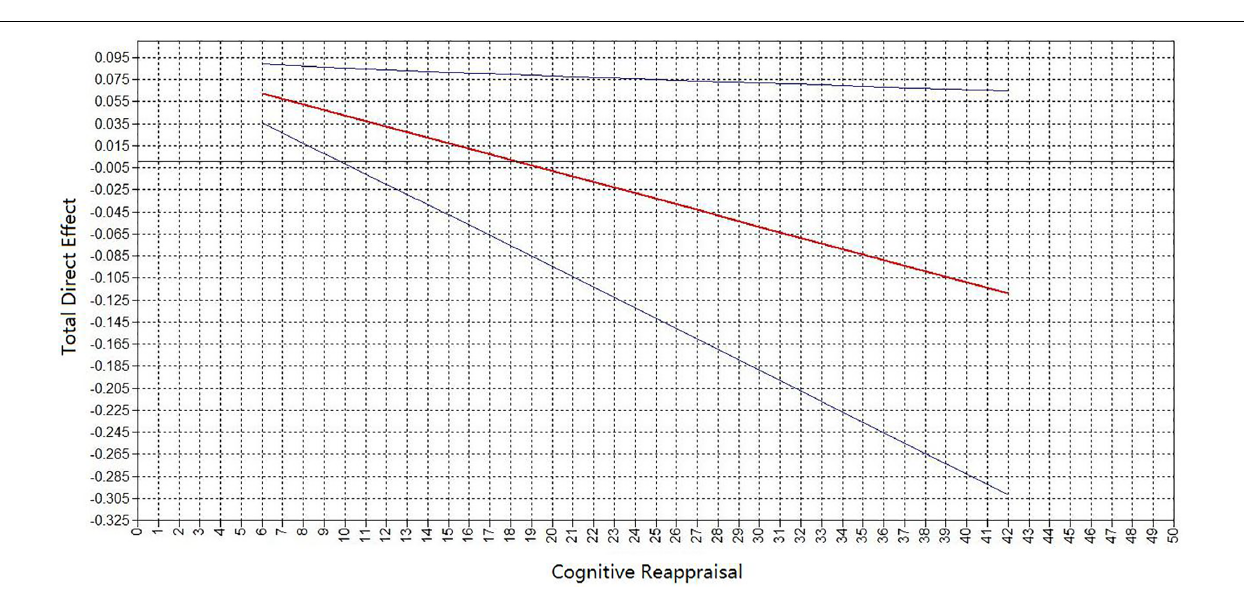
FIGURE 3 | Graphical representation of cognitive reappraisal moderation of a total direct effect between work stress and depressive symptoms. Predicted slopes for the relationship between work stress and depressive symptoms in relation to cognitive reappraisal (score range, 6–42) for Chinese fishermen with a smoking habit. The middle red line represents the total direct effect between work stress and depressive symptoms; such that the steepness of the slope reflects the strength of the moderating influence (a slope of 0 would indicate no moderating effect). Note that the higher the emotion regulation score for cognitive reappraisal ( x axis value), the weaker the total direct effect is ( y axis value). The area between the upper and lower (blue) lines represents the CI of the total direct